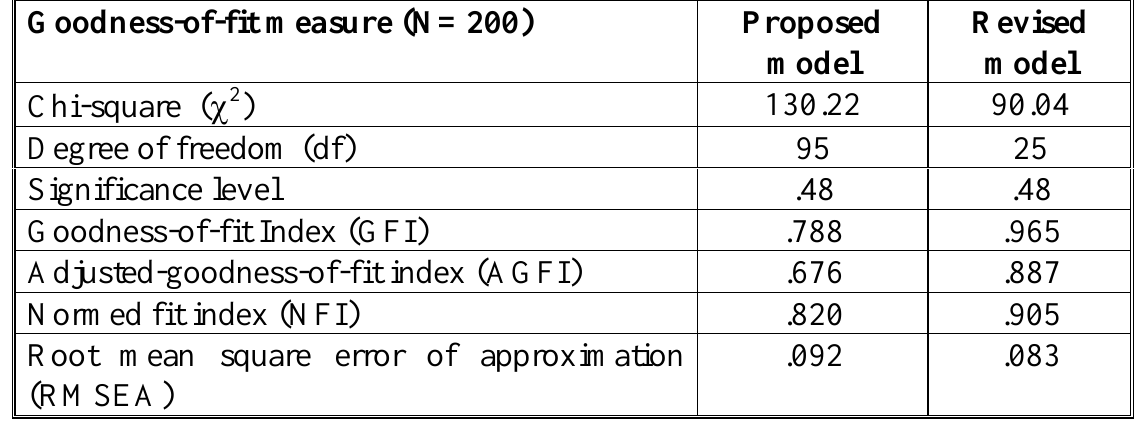
Table 5 Assessment of goodness-of-fit